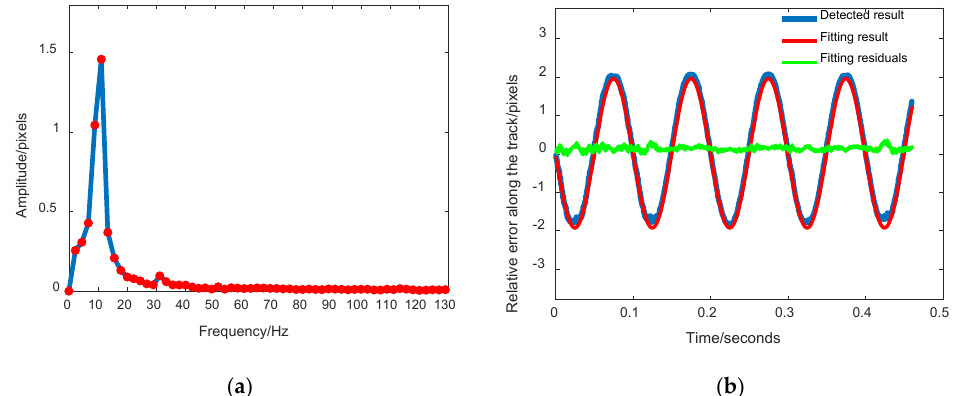
Figure 14. Analysis results of 100-Hz jitter detection curve after interpolation by sequential disparity maps. ( a ) Fourier analysis results; ( b ) Fitting results.